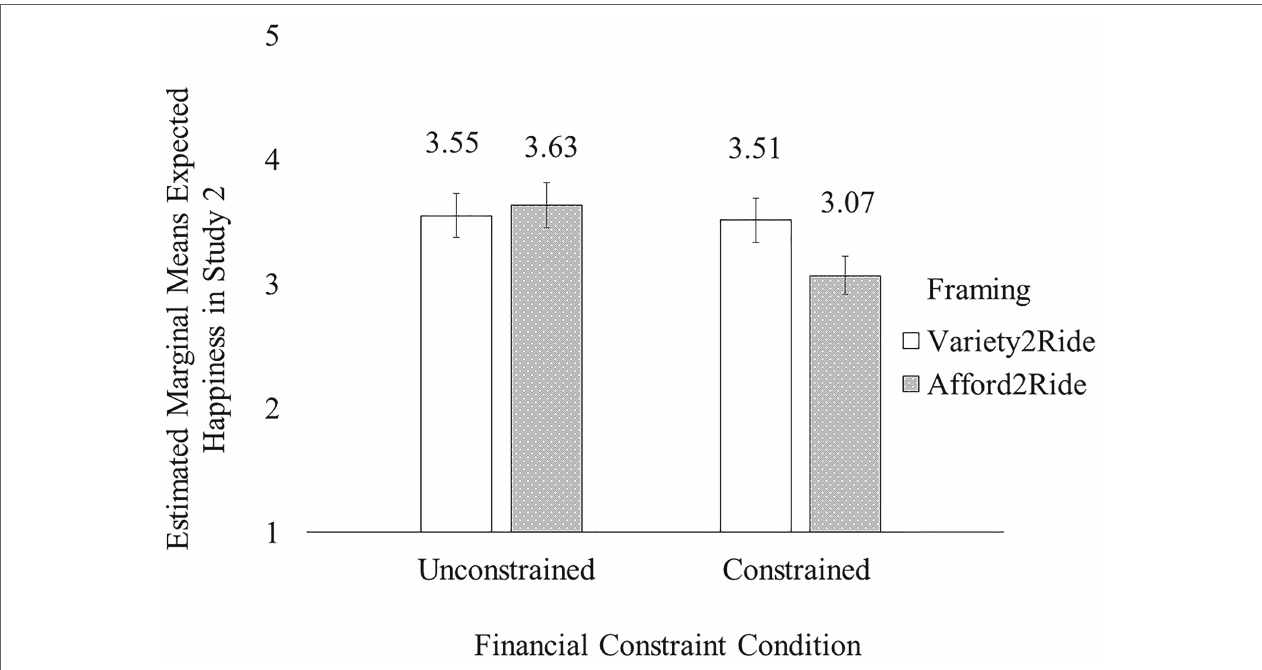
FIGURE 2 | The financial constraints × framing interaction effect on happiness in Study